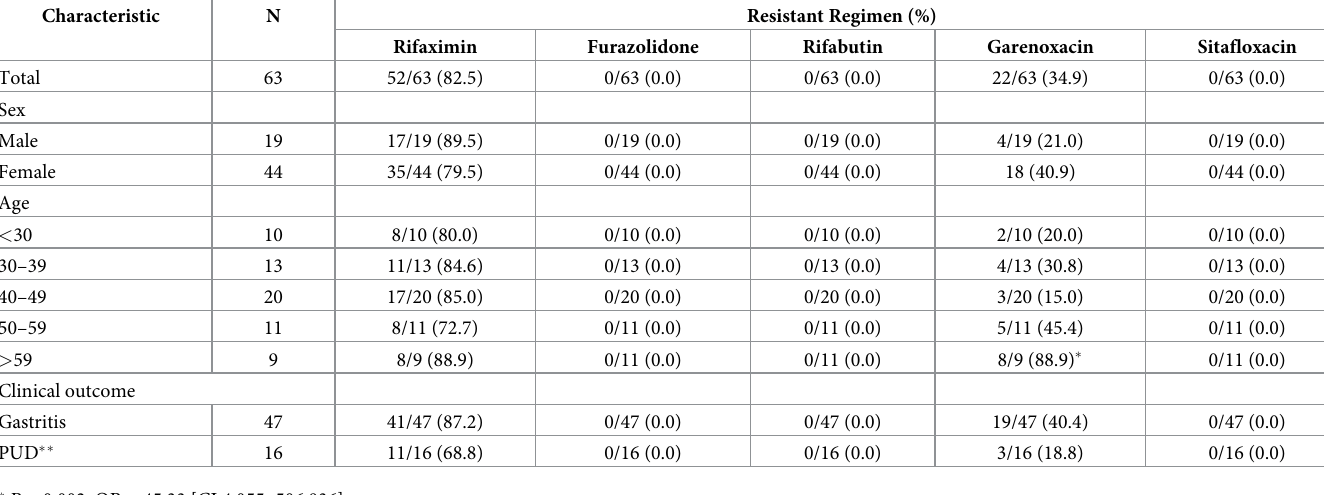
Table 1. Distribution of antibiotic resistance in the Dominican Republic. Characteristic